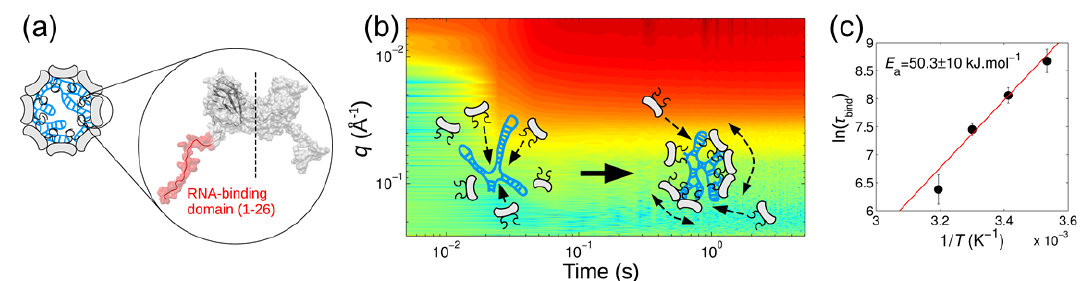
Figure 9. Assembly of icosahedral virus particles from the constituent capsids. ( a ) Schematic view of a virus particle with dimeric subunits and RNA genome. The expanded view displays the molecular structure of the subunit with one of its RNA binding domains. ( b ) Evolution of the SAXS intensity during the assembly process. The cartoon shows the rapid binding of subunits onto the genome and then the slow reorganization of the complex to the final structure. ( c ) Arrhenius plot of the binding time constant ( τ bind ) deduced from low q SAXS intensity at different temperatures, which provided an estimate of the activation energy ( E a ). Adapted from M. Chevreuil et al. [84] licensed under